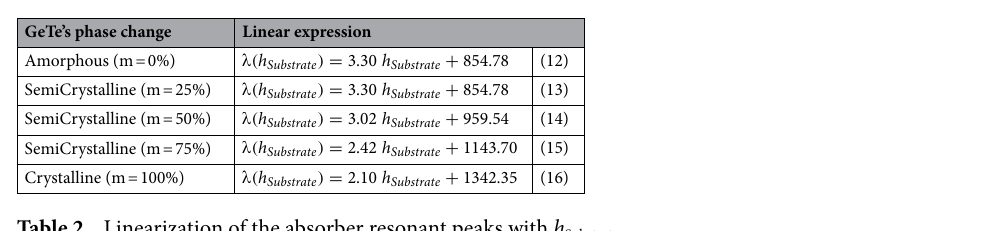
Table 2. Linearization of the absorber resonant peaks with h Substrate